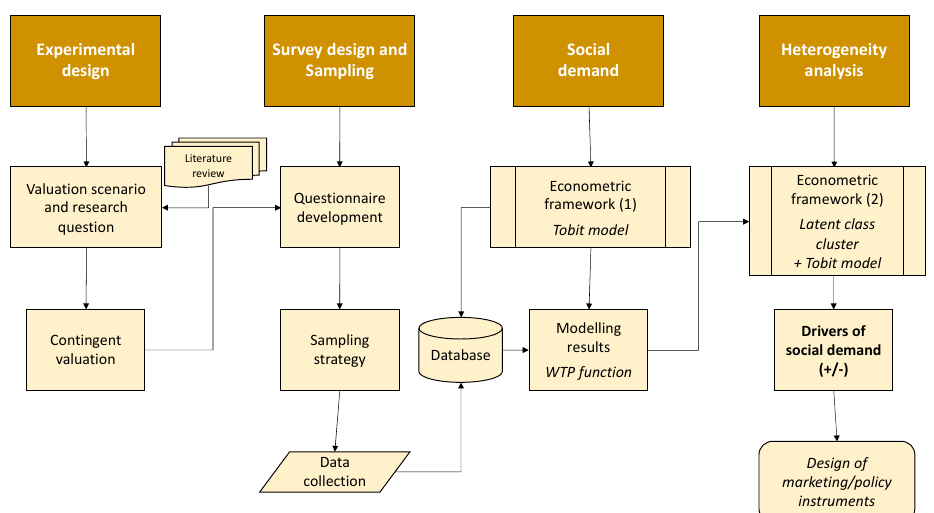
Figure 2. Flowchart. Process followed in the research framework.